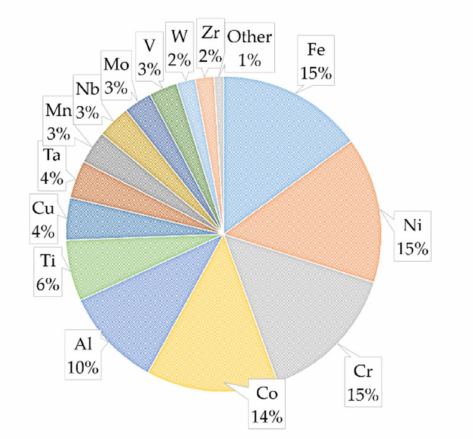
Figure 2. High-entropy alloy base element